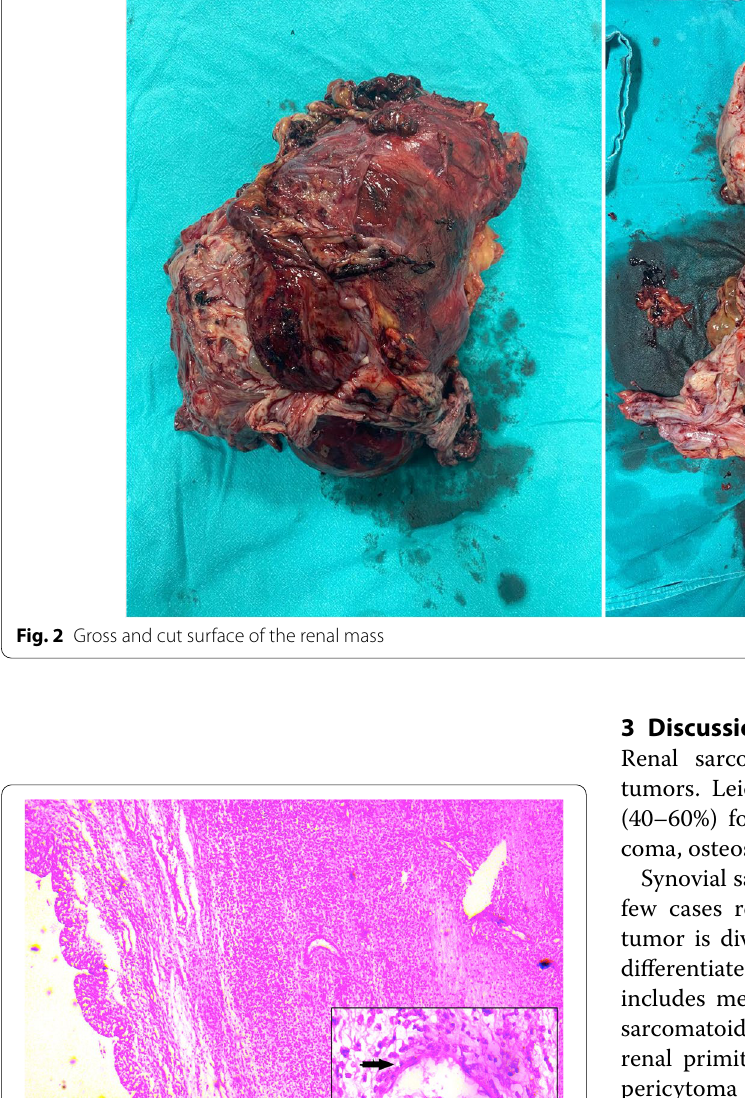
10). Inset showing × ×